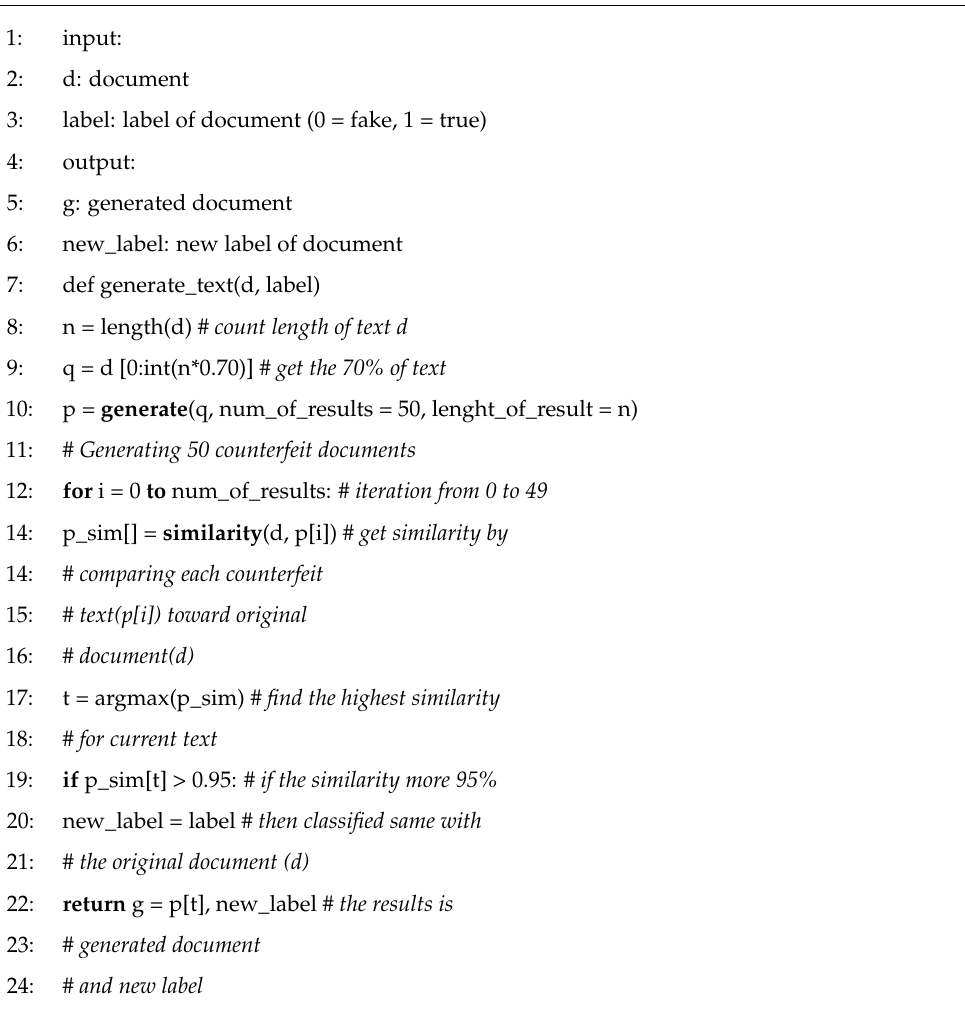
Algorithm 1. Document generation and